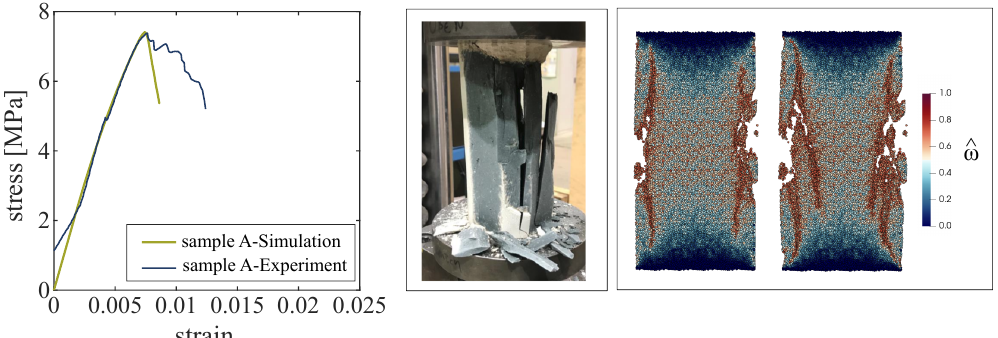
Figure 7. ( Left ): Uniaxial compression of sample A: Load–displacement curves obtained from the experiment (black line) and the DEM simulation (green line). ( Middle ): Photo of the damaged sample A after the uniaxial compression test in the laboratory. ( Right ): Damage pattern obtained from the DEM simulation at two stages of compressive loading: at 6.714 kN/cm 2 (post peak), and 5.461 kN/cm 2 (post peak) in the cross section of the cylindrical sample